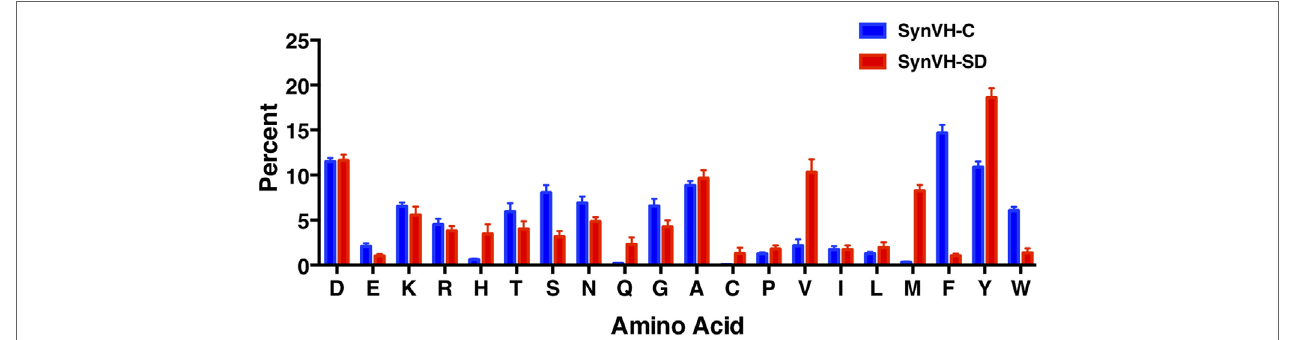
FigUre 4 | SynVH-C and SynVH-SD amino acid frequencies in CDR-H3 are similar for most amino acids. The frequency of each amino acid out of the total amino acid content in CDR-H3, IMGT positions 105–117. Specific CDR-H3 lengths of 12, 13, 14, and 15 residues from the top 1,000 unique sequences from each bird were used to calculate the frequencies, which were then averaged. Error bars indicate bird-to-bird variation; SynVH-C, N = 6 birds, SynVH-SD, N = 3